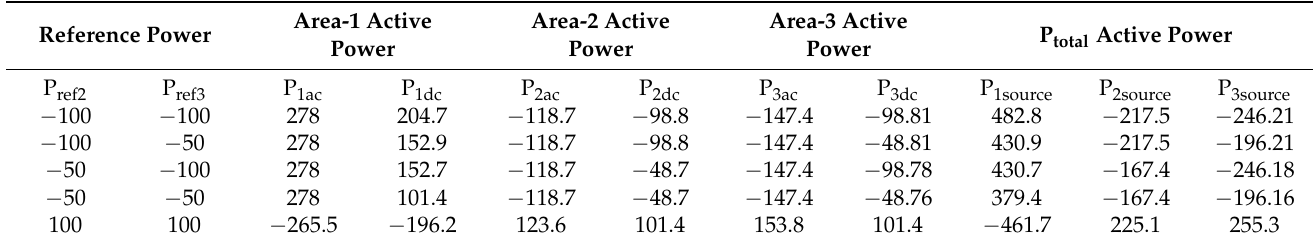
Table 2. Active power flow for all three power system areas; (power are in MW).